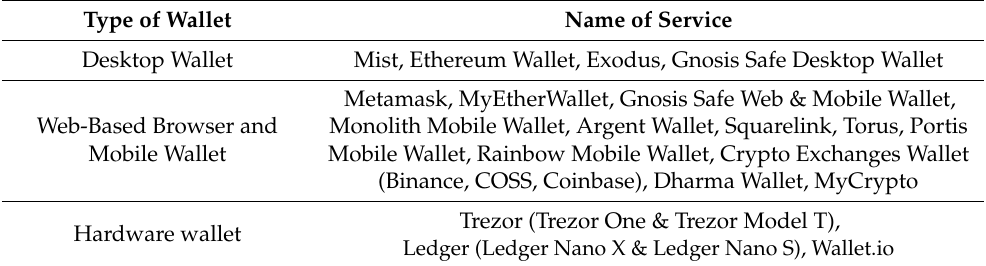
Table 4. Types of